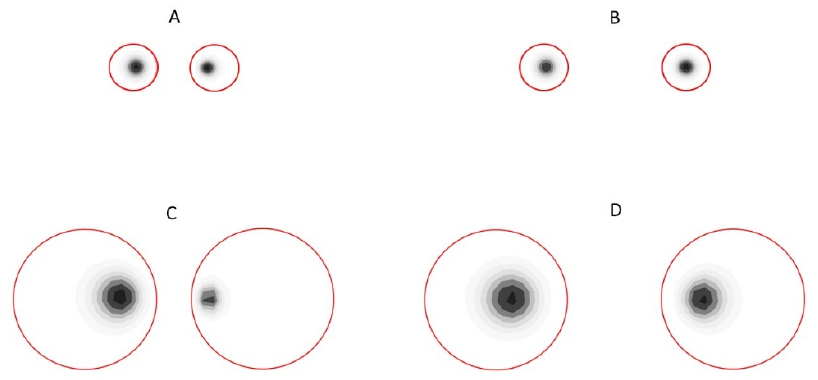
Figure 2. Charge densities of electron and hole across corresponding neighbouring parallel NWs of diameter D obtained by direct quantum mechanical calculations (see Appendix A) for different values of the NW diameter D and h . ( A ) h = 1 nm, D = 1.5 nm; ( B ) h = 3 nm, D = 1.5 nm; ( C ) h = 1 nm D = 5 nm; ( D ) h = 3 nm, D = 5 nm.